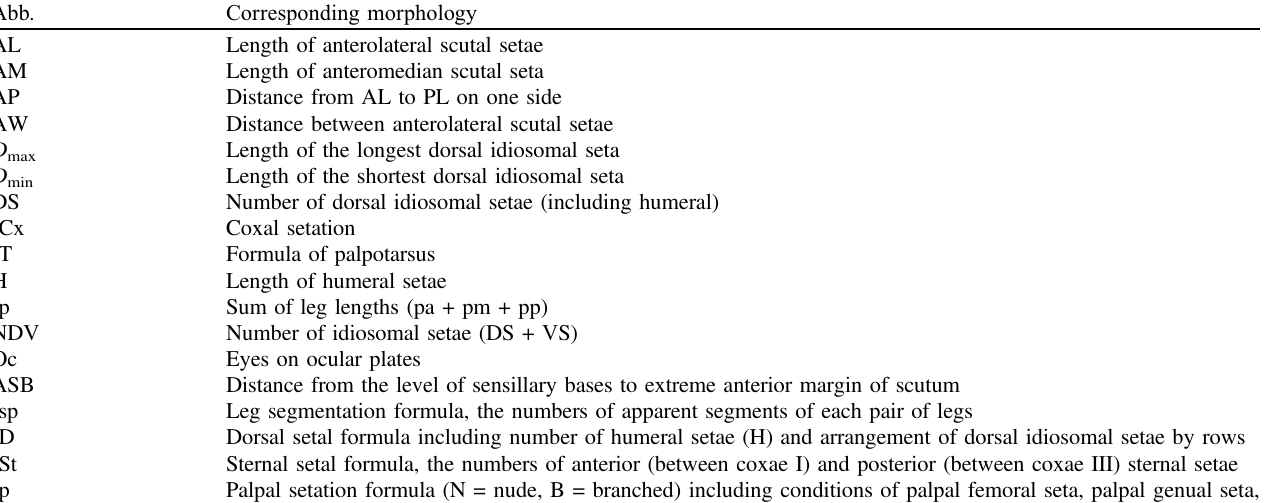
Table 2. The related taxonomic morphology of chiggers, the larvae of chigger mites (cited from Stekolnikov, 2013 [49]).